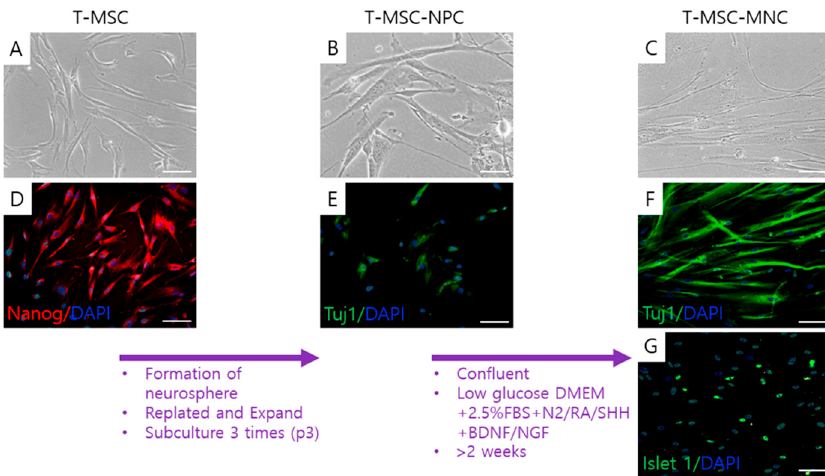
Figure 1. Schematic of di ff erentiation of tonsil-derived mesenchymal stem cells (T-MSCs) toward motor neuron (MN)-like cells (MNCs). ( A ) The undi ff erentiated T-MSCs were induced to ( B ) T-MSC-derived neural precursor cells (T-MSC-NPCs). ( C ) T-MSC-MNCs were induced by culturing T-MSC-NPCs in MN di ff erentiation medium for 14 days. Expression of pluripotent ( D ; Nanog; red), neuronal ( E , F ; Tuj1; green), motor neuronal markers ( G ; Islet 1; green) and total cell ( D – G ; DAPI; blue) was examined using immunocytochemistry in cells at each stage. Scale bars = 100 µ m. Tuj1, β -III tubulin; DAPI, 4 (cid:48) ,6-diamidino-2-phenylindole; RA, retinoic acid; Shh, sonic hedgehog; BDNF, brain-derived neurotrophic factor; NGF, nerve growth